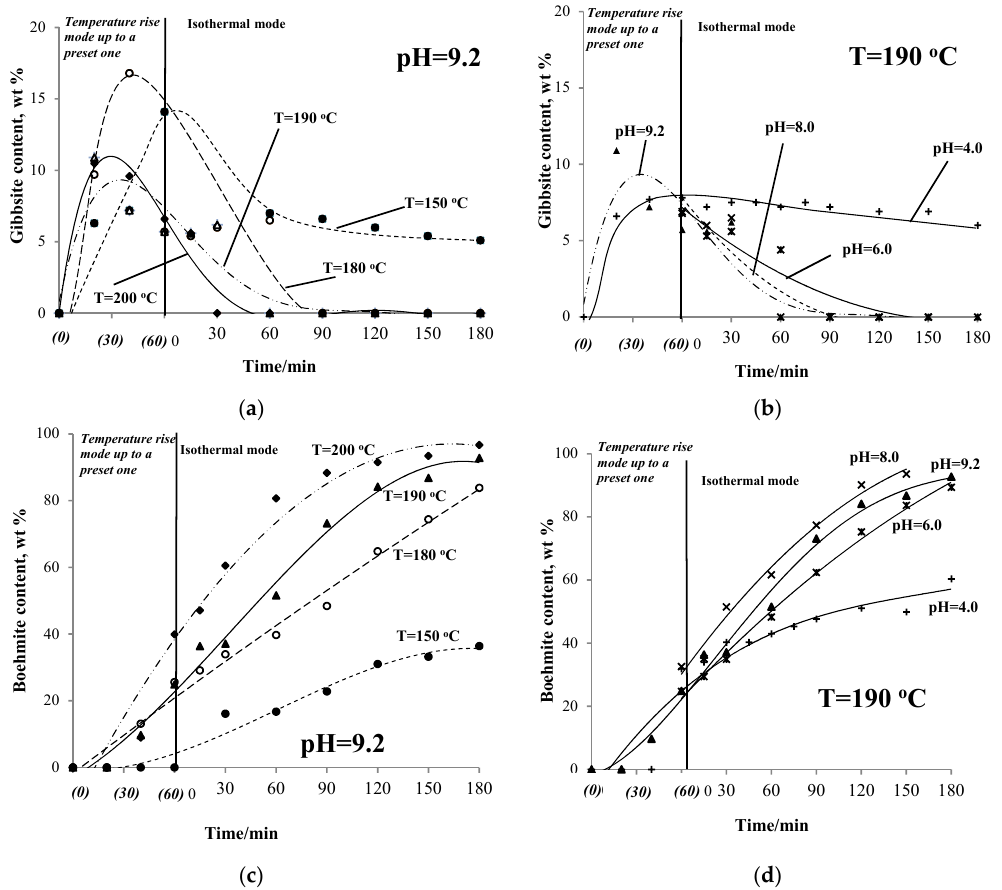
Figure 5. Dependences of an aluminum hydroxides content on the on the duration in the χ‐ Al 2 O 3 HTT products ( a , c ) at the different temperatures and ( b , d ) pH value of an aqueous suspension.